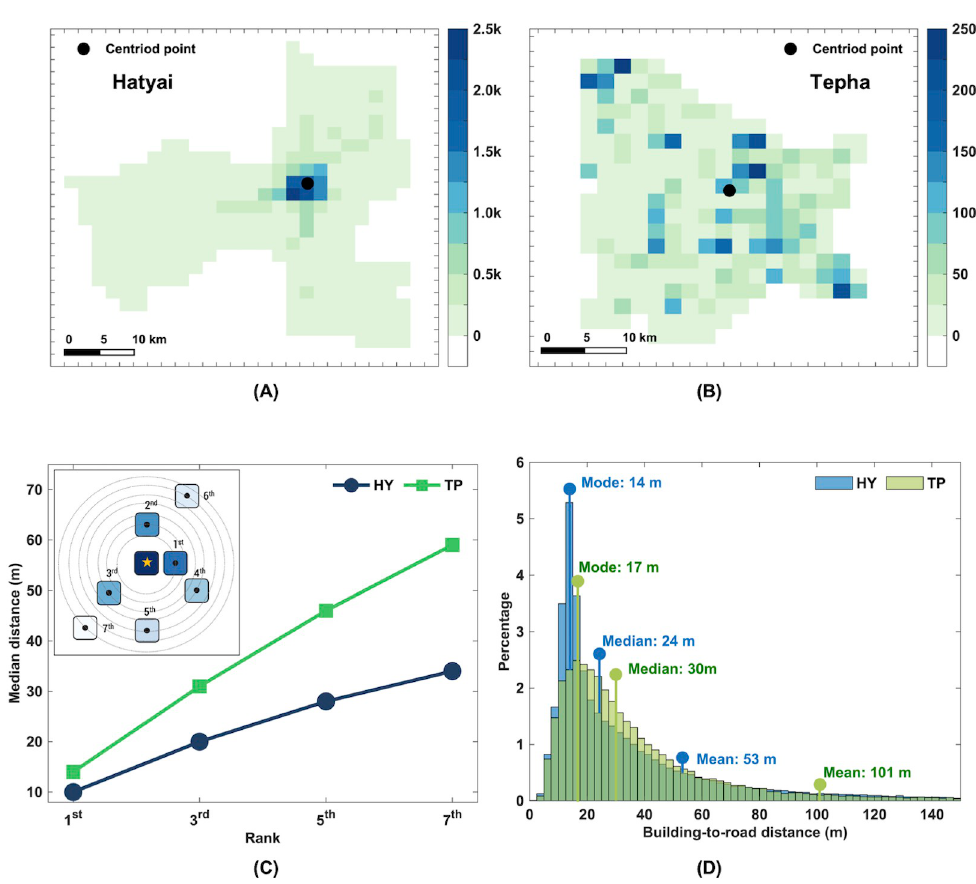
Fig 3. Building density and distribution. (A and B) Spatial distribution of building density in Hatyai and Tepha. The color bar indicates the building density in the unit of buildings per square kilometer. Note that the color bar in Hatyai represents 10 times higher building density than in Tepha. The black circles show the centroid points of the building distribution. (C) The median pairwise distance between two buildings with a different rank of closeness (from shortest to longest) in Hatyai (HY) and Tepha (TP) district. The inset illustrates an example of a building arrangement with different ranks of closeness relative to the stared building. (D) The distribution of the shortest building-to-road distance in Hatyai (HY) and Tepha